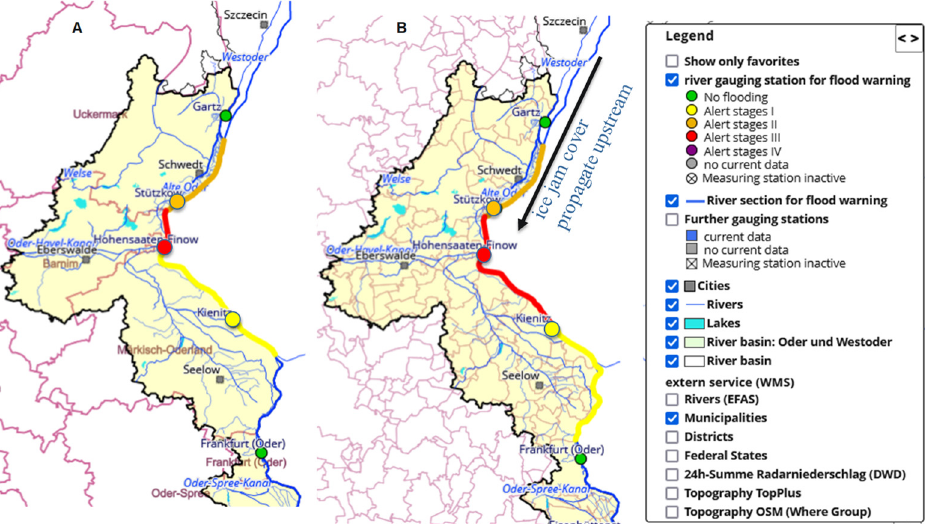
Figure 13. Tracking an ice-jam cover progression using the alert level system, which links gauge readings to upstream river reaches (source: Landesamt für Umwelt Brandenburg) with ( A ) for normal flood conditions and ( B ) for ice-jam conditions.